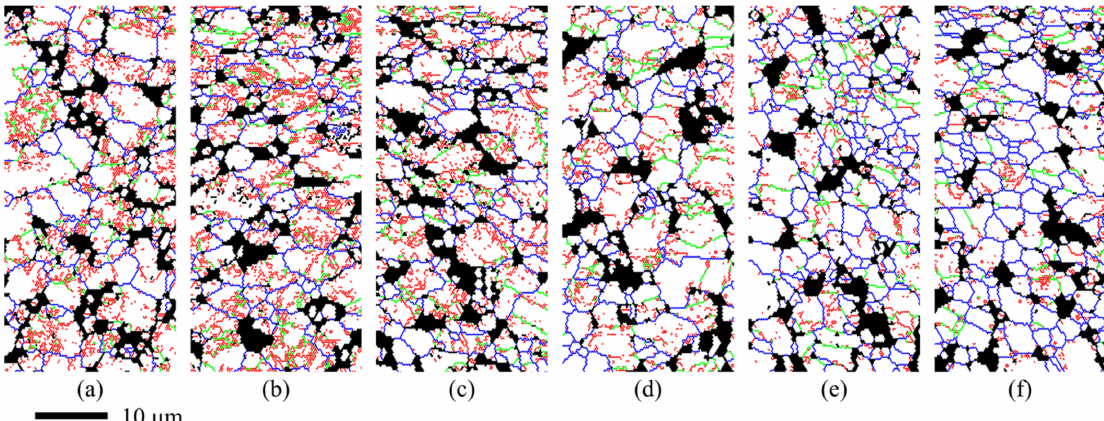
Figure 12. The distributions of the grain boundary at different strains when deformed at 950 ◦ C and 0.01 s − 1 : ( a ) Initial; ( b ) 0.1; ( c ) 0.3; ( d ) 0.5; ( e ) 0.7; ( f ) 0.9 (red lines represent LAGBs less than 5 ◦ , green lines represent MAGBs between 5 ◦ ~15 ◦ , blue lines represent HAGBs more than 15 ◦ ).